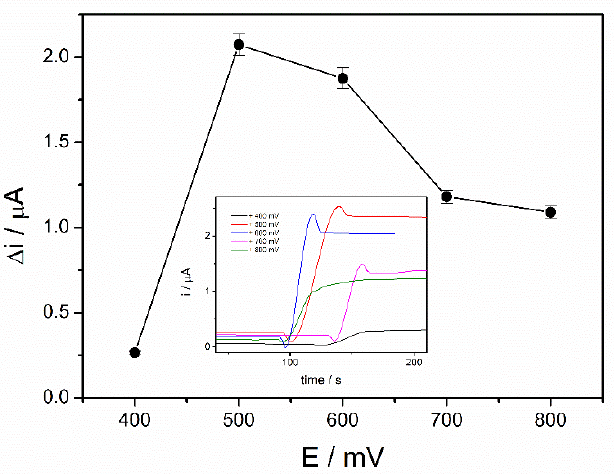
Figure 2. Influence of working potential on the biosensor response (PBS 0.1 M pH = 8.8, 10 mM NAD + , 4 mM ethanol, n = 3) (inset: chronoamperometric response curves at an applied potential between +400 and +800 mV).